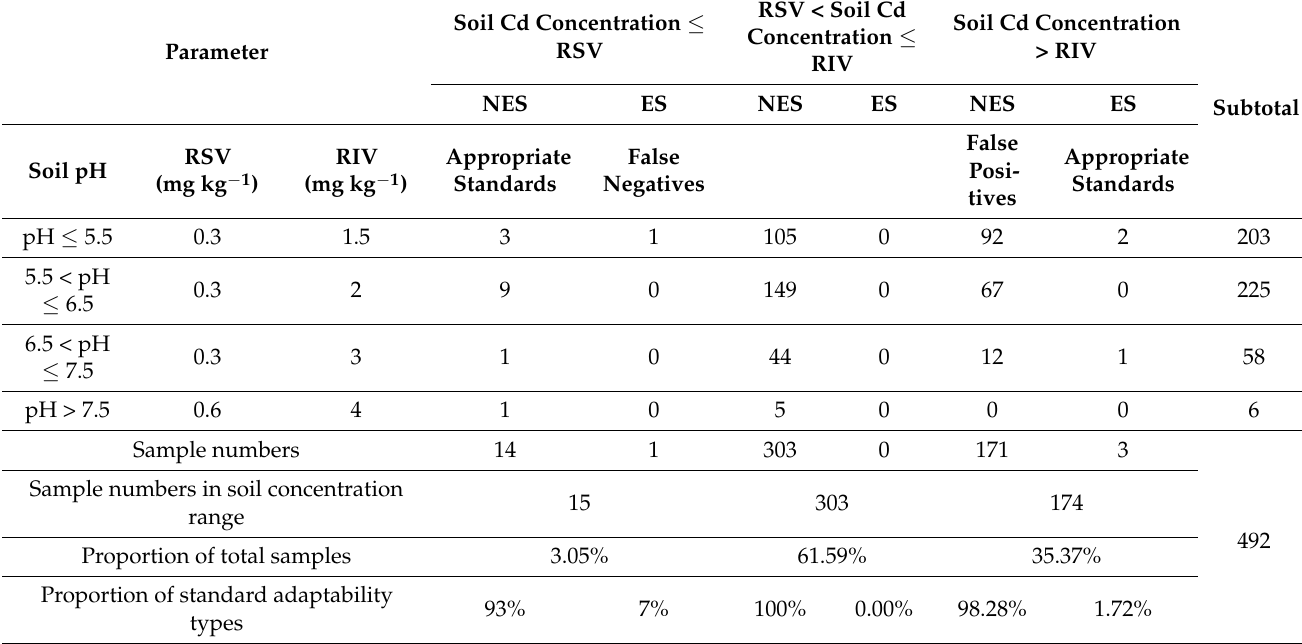
Table 2. Suitability of the current Chinese Environmental Quality Standards (EQSs) for soil contami- nation of agricultural land in the classification of soil environmental quality for the research